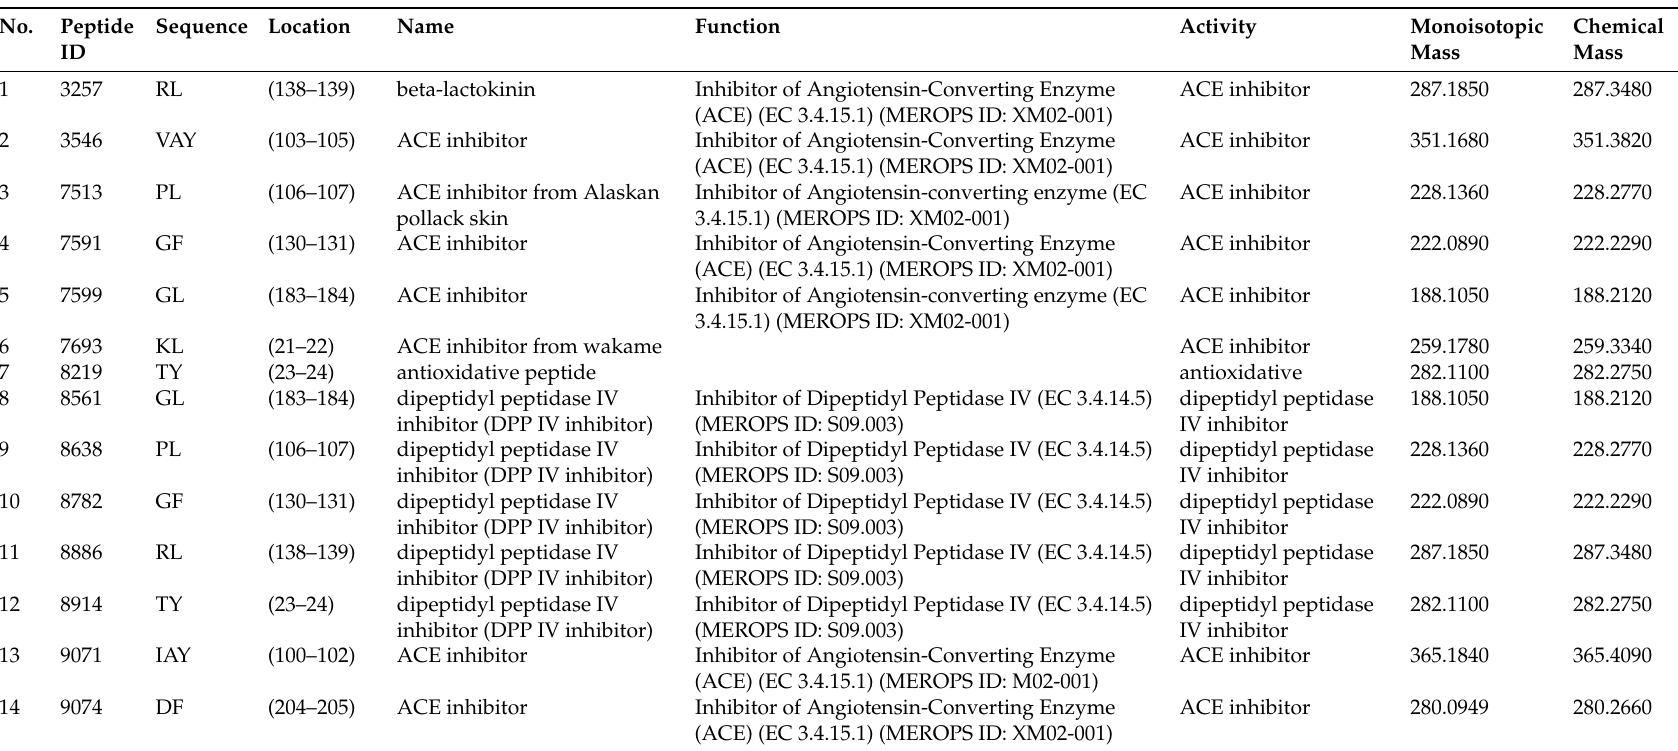
Table A33. Bioactive peptides from RubisCO of Halophila stipulacea . In silico enzymatic cleavage was carried out by using